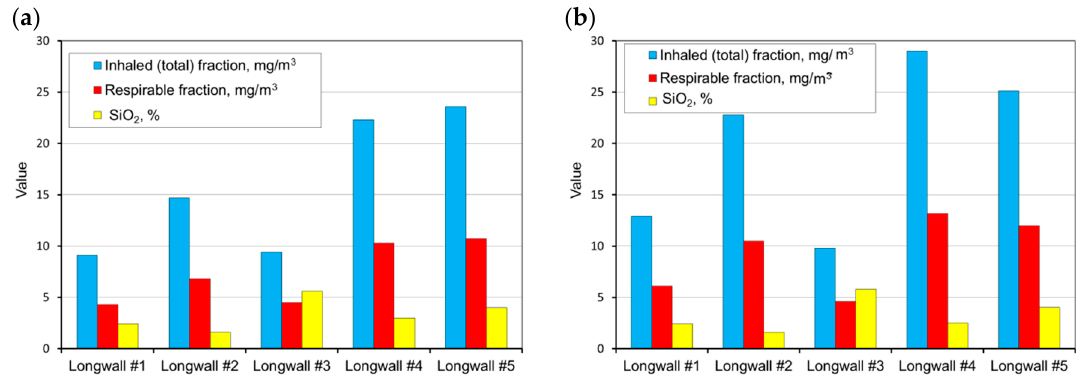
Figure 4. The measurement results for the dust levels in the positions of the cutter-loader man ( a ) and the miner working between the shearer and the air outlet from the longwall ( b ) (workplaces 1 and 4).